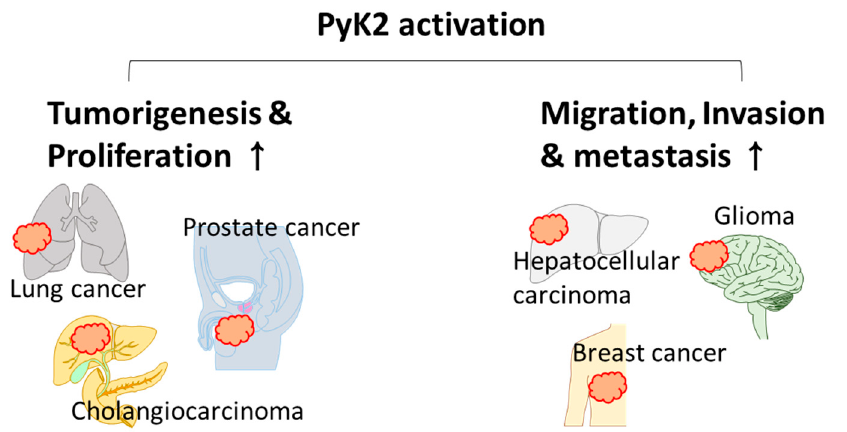
Figure 2. Schematic illustration of the effect of PyK2 on various cancers. PyK2 activation enhances tumorigenesis, cancer proliferation, migration, invasion, and metastasis. The affected cancers are lung cancer, prostate cancer, cholangiocarcinoma, hepatocellular carcinoma, glioma, and breast cancer.